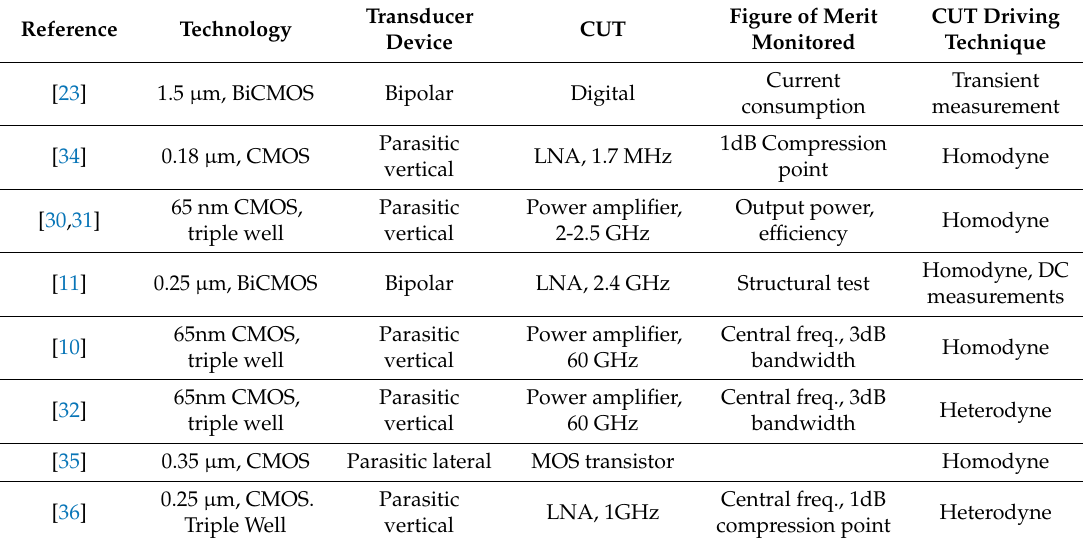
Table 1. Comparison of di ff erent di ff erential temperature sensor implementations.